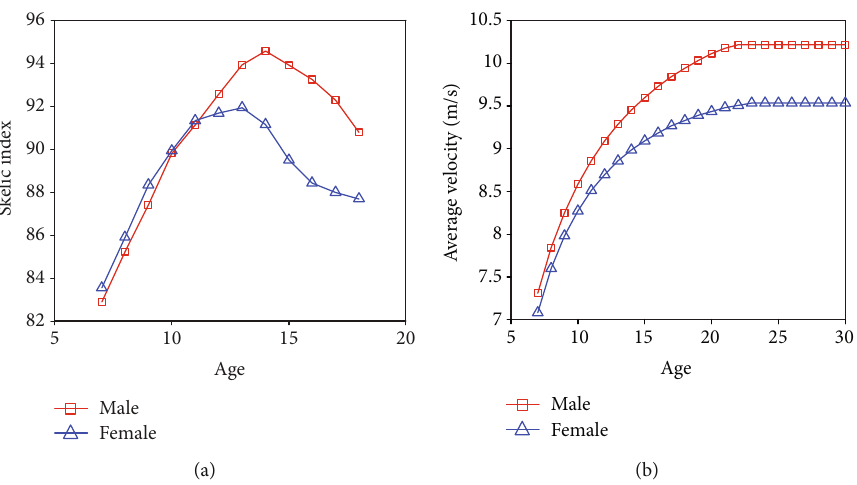
Figure 5: (a) The development curve of skelic index and age [69]. (b) The development curve of average velocity of 100 m sprint best record and age